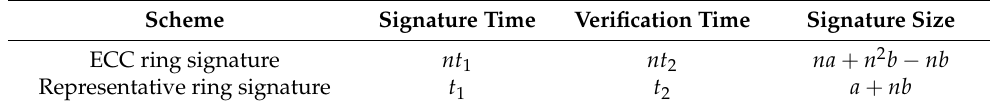
Table 1. The performance comparison of two schemes.